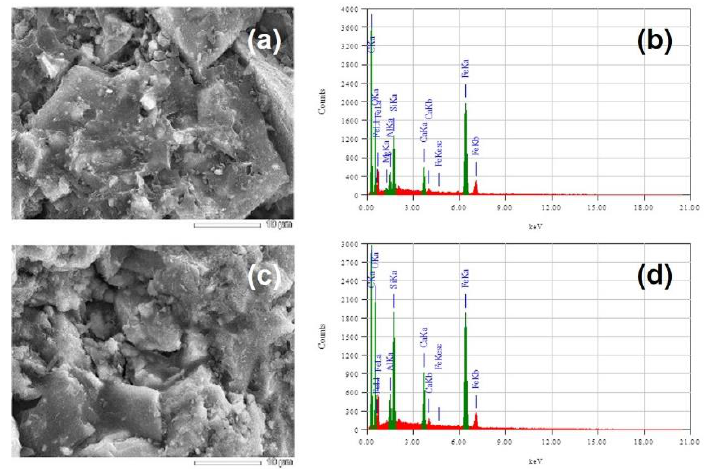
Figure 5. SEM images showing a change in iron ore surfaces after carbonization of impregnated ore and the results of EDX analyses: ( a , b ) Sample D1, ( c , d ) Sample D2.